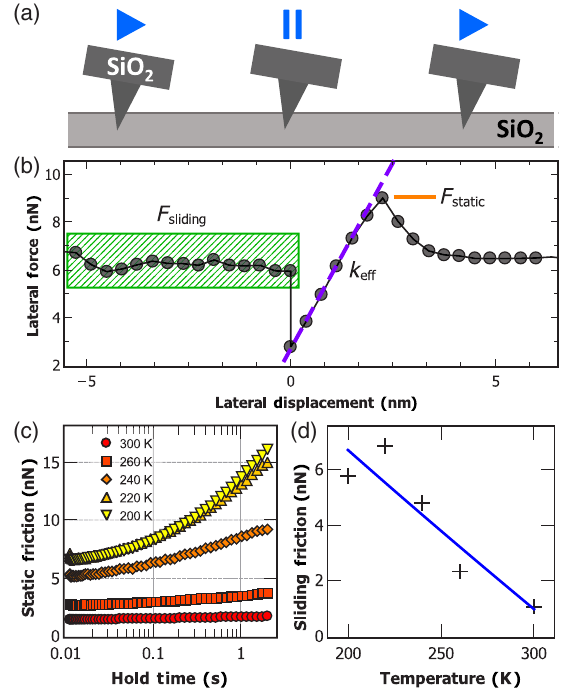
FIG. 1. Slide-hold-slide experiments performed on SiO 2 . (a) Schematic course of a typical slide-hold-slide procedure, where tip movement is paused for a defined amount of time. (b) Exemplary slide-hold-slide curve obtained for silica on native ¼ 2 . 1 s. The x axis is relative to the silica at 200 K with t hold stopping point. As indicated in the figure, various characteristic quantities are evaluated around the stopping point. Especially important are the sliding friction level F (green), the static sliding friction peak F (orange), and the contact stiffness k , which can static be derived from the slope of the lateral force buildup (purple, extrapolated as dashed line). (c) Hold time dependence of the static friction for different temperatures between 200 K (yellow) and 300 K (red) measured on the native oxide layer. (d) Temperature dependence of the sliding friction ( v ¼ 2 . 5 μ m = s) for the native oxide silica (crosses) fitted by a theoretical curve (blue line) based on the standard model describing thermally activated